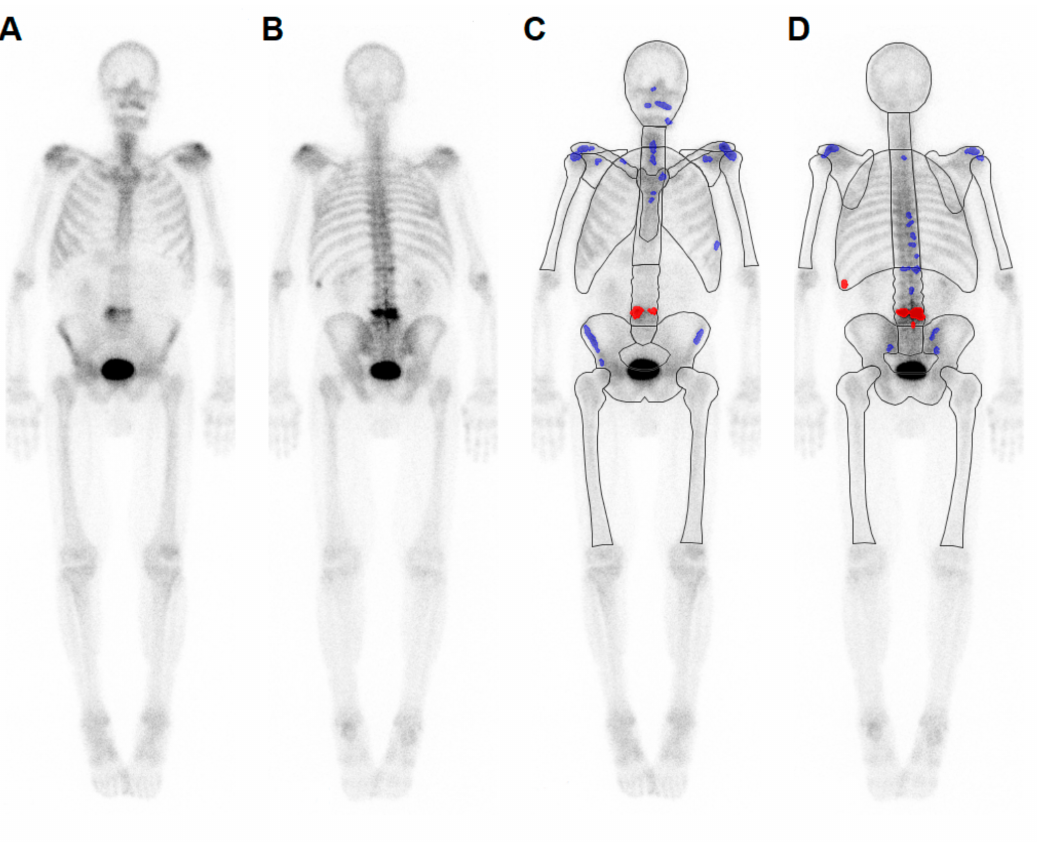
Figure 3. ( A , B ) Bone scan of a male patient with colorectal cancer and ( C , D ) results from atlas-based segmentation. Three lesions were correctly identified as osseous metastases (lumbar spine and left rib, red labeled). The malignant character is in accordance with the medical report (BSI = 0.54%). Additional benign lesions were labeled in blue; ( A , C : anterior projection; B , D : posterior